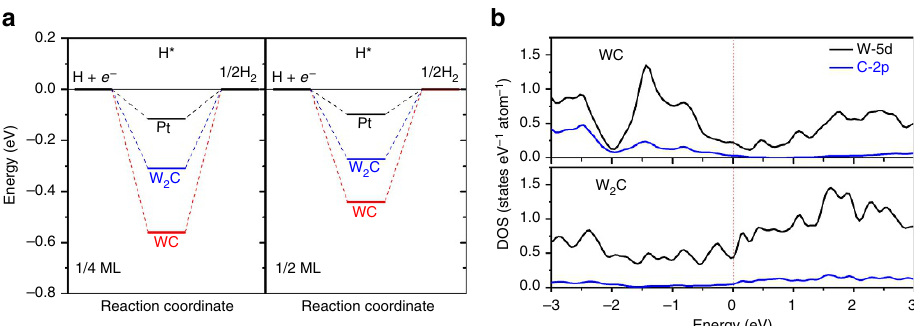
Figure 1 | DFT computations on the HER activity and electronic structure of W 2 C. ( a ) Free-energy diagrams for HER on the (0001) surfaces of W 2 C and WC, as well as Pt (111) surface at both low (1/4 ML H ) and high (1/2 ML H ) hydrogen adsorption coverage. ( b ) Calculated partial density of states of W and C atoms in W 2 C and WC. The red dashed line denotes the position of the Fermi